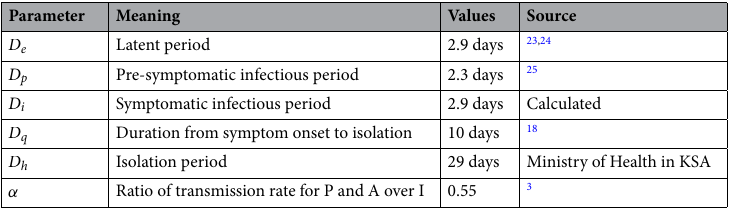
Table 1. Description of key model parameters not fitted in the MCMC.